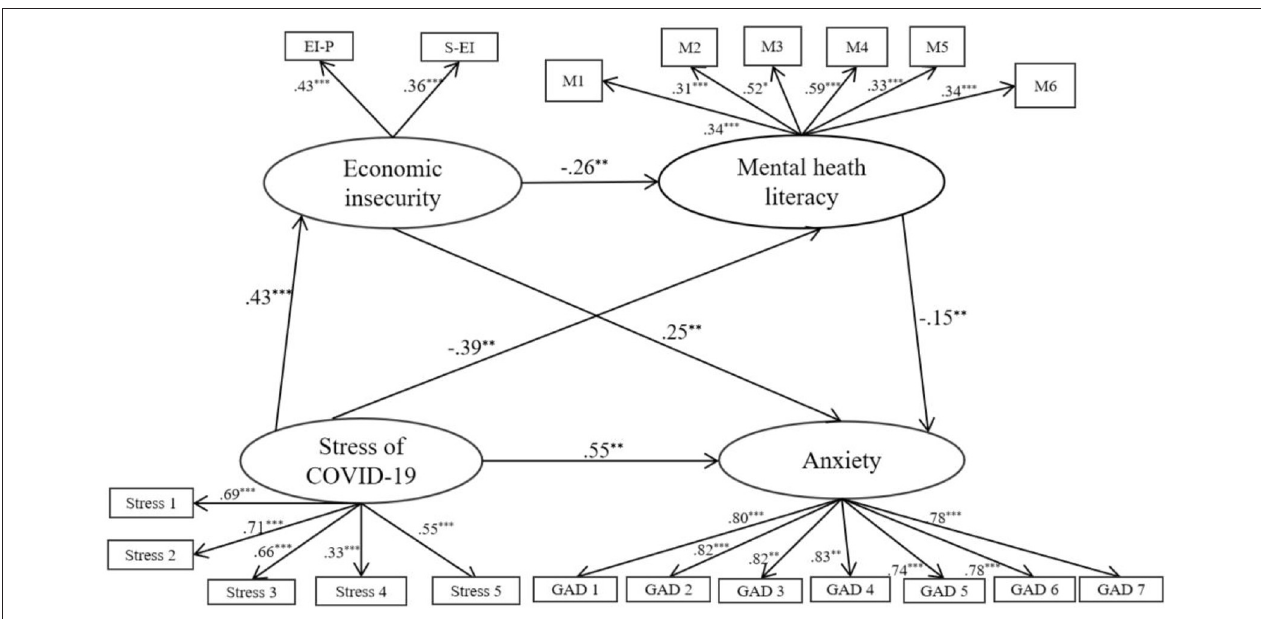
FIGURE 2 | Structural equation model of the proposed